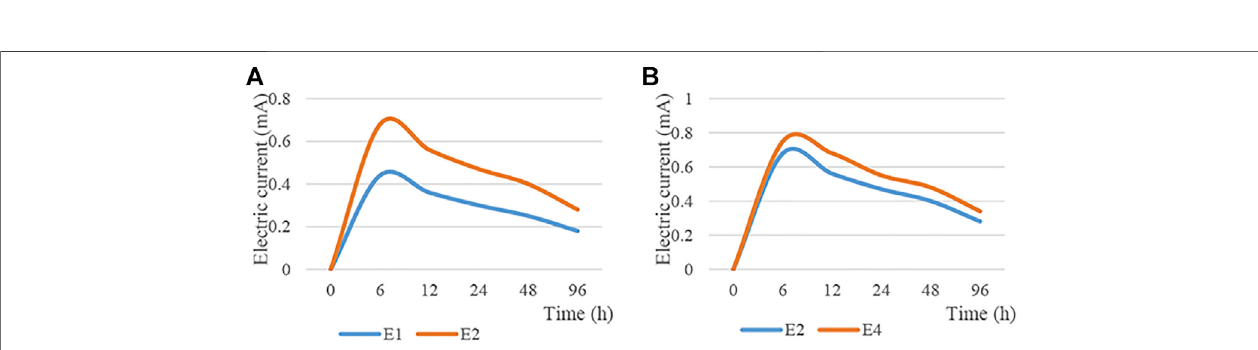
FIGURE8| Variationofcurrentunderdifferentexperimentalconditions. (A) showstheeffectofelectrolytetypeoncurrent. (B) showstheeffectofdifferentvoltages on current.